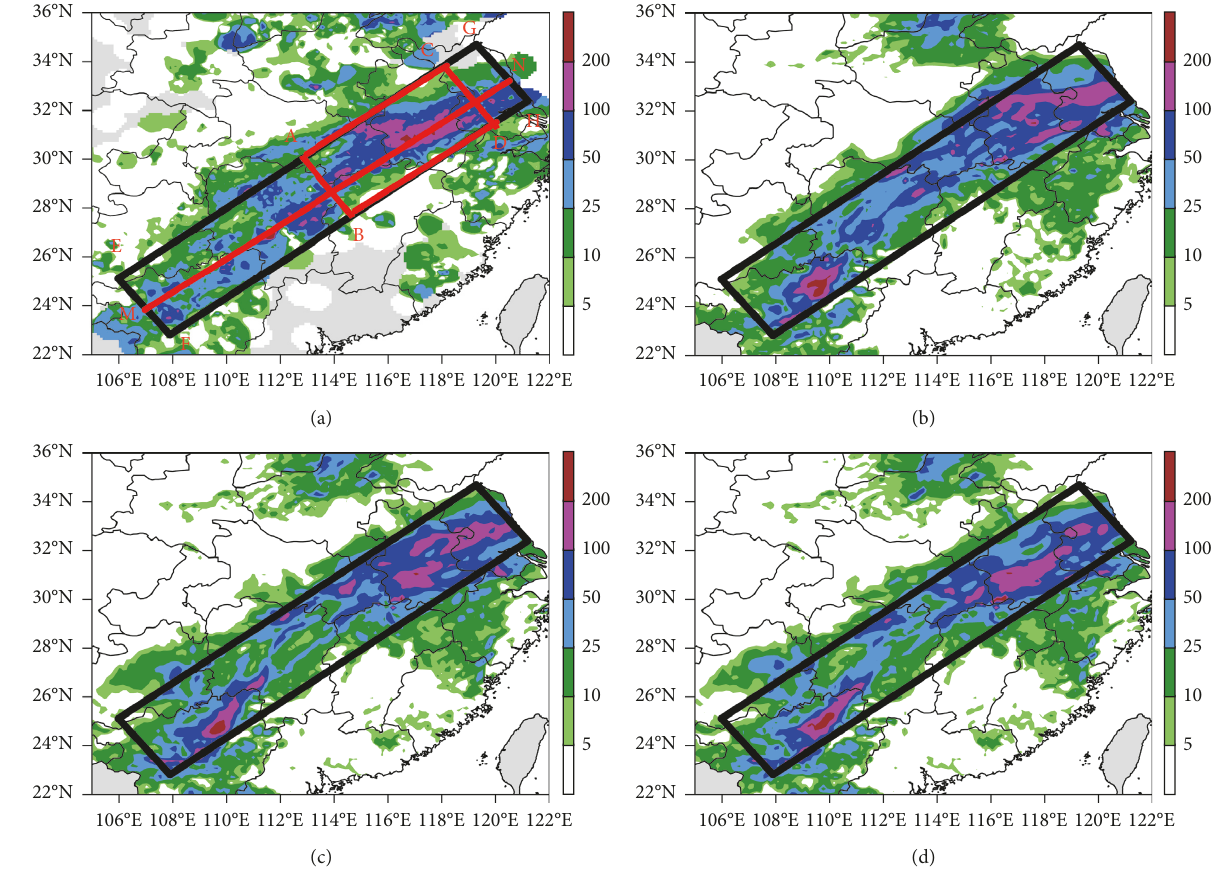
Figure 3: Twenty-four-hour accumulated precipitation for the period 0000 UTC 4 July to 0000 UTC 5 July 2014 from observations (a) and simulations in (b) CON, (c) RAD, and (d) RADC (unit: mm). The black and red solid boxes represent the main rainfall belt and the key rainstorm area with 24h accumulated precipitation amount greater than 100mm,